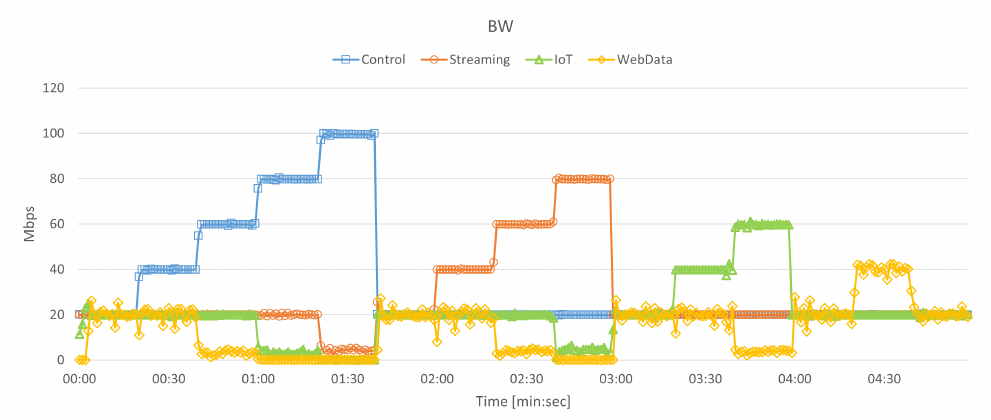
Figure 8. Bandwidth obtained from the scenario using the second